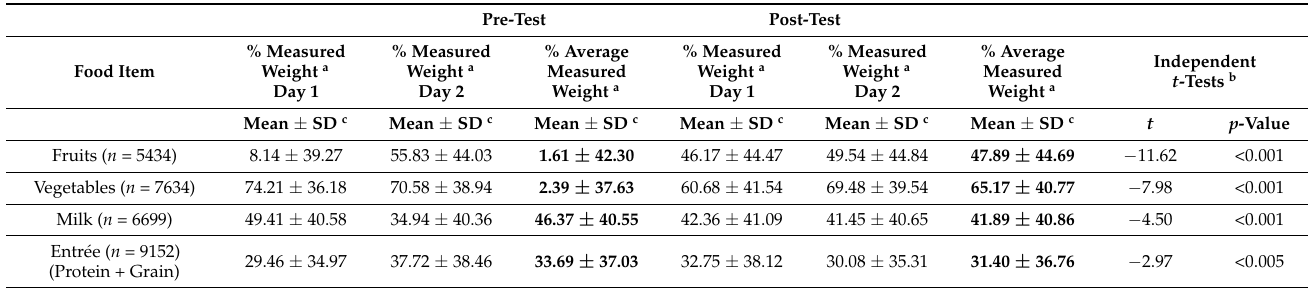
Table 2. Differences in Average Percent of Food Waste by Food Component per Tray at Pre- and Post-Test Intervention ( n =